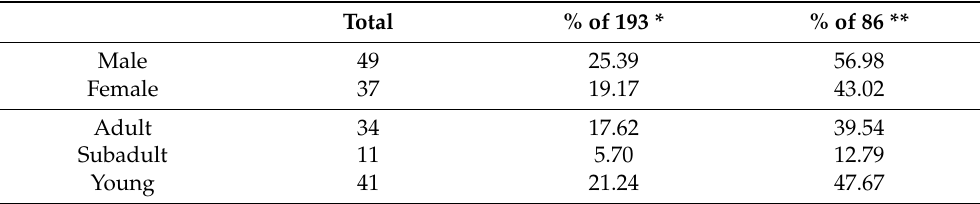
Table 2. Prevalence of genotypically confirmed Campylobacter in all tested wild boars ( n = 193) and in the wild boars harbouring genotypically confirmed Campylobacter ( n = 86), categorized by sex and